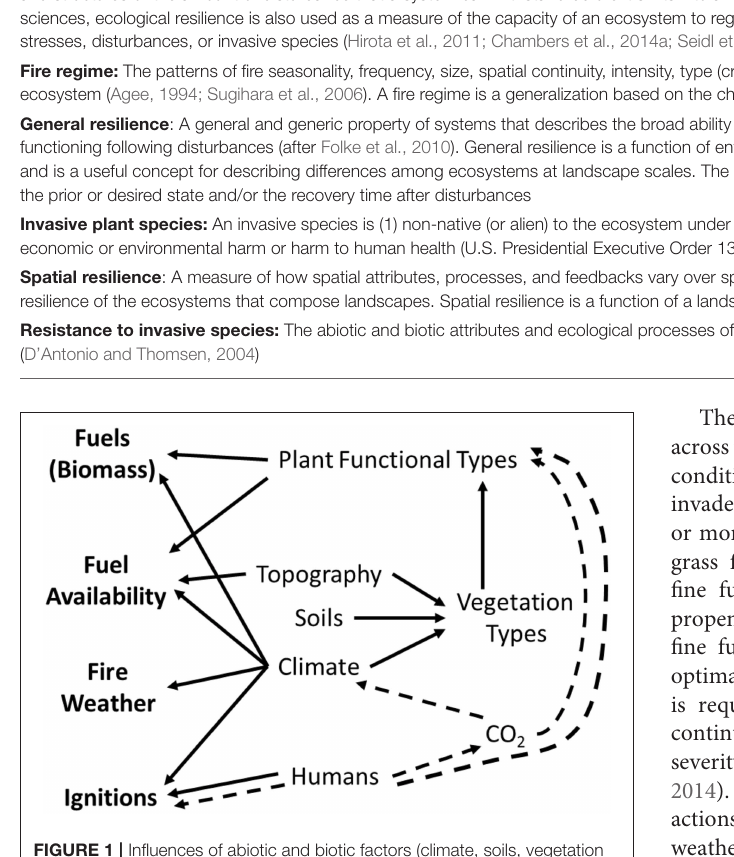
TABLE 1 | Definitions used in this paper. Ecological resilience: A measure of the amount of change needed to change an ecosystem from one set of processes and structures to a different set of processes and structures or the amount of disturbance that a system can withstand before it shifts into a new regime or alternative stable state (Holling, 1973). In the applied